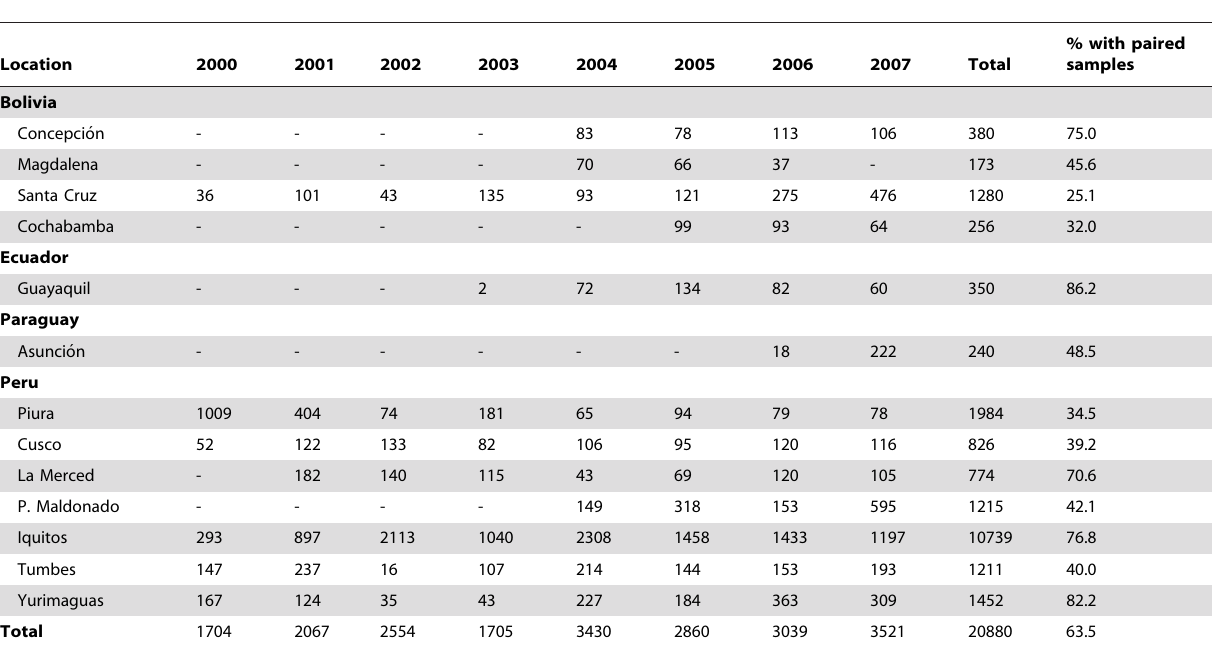
Table 2. Total febrile participants, by location and